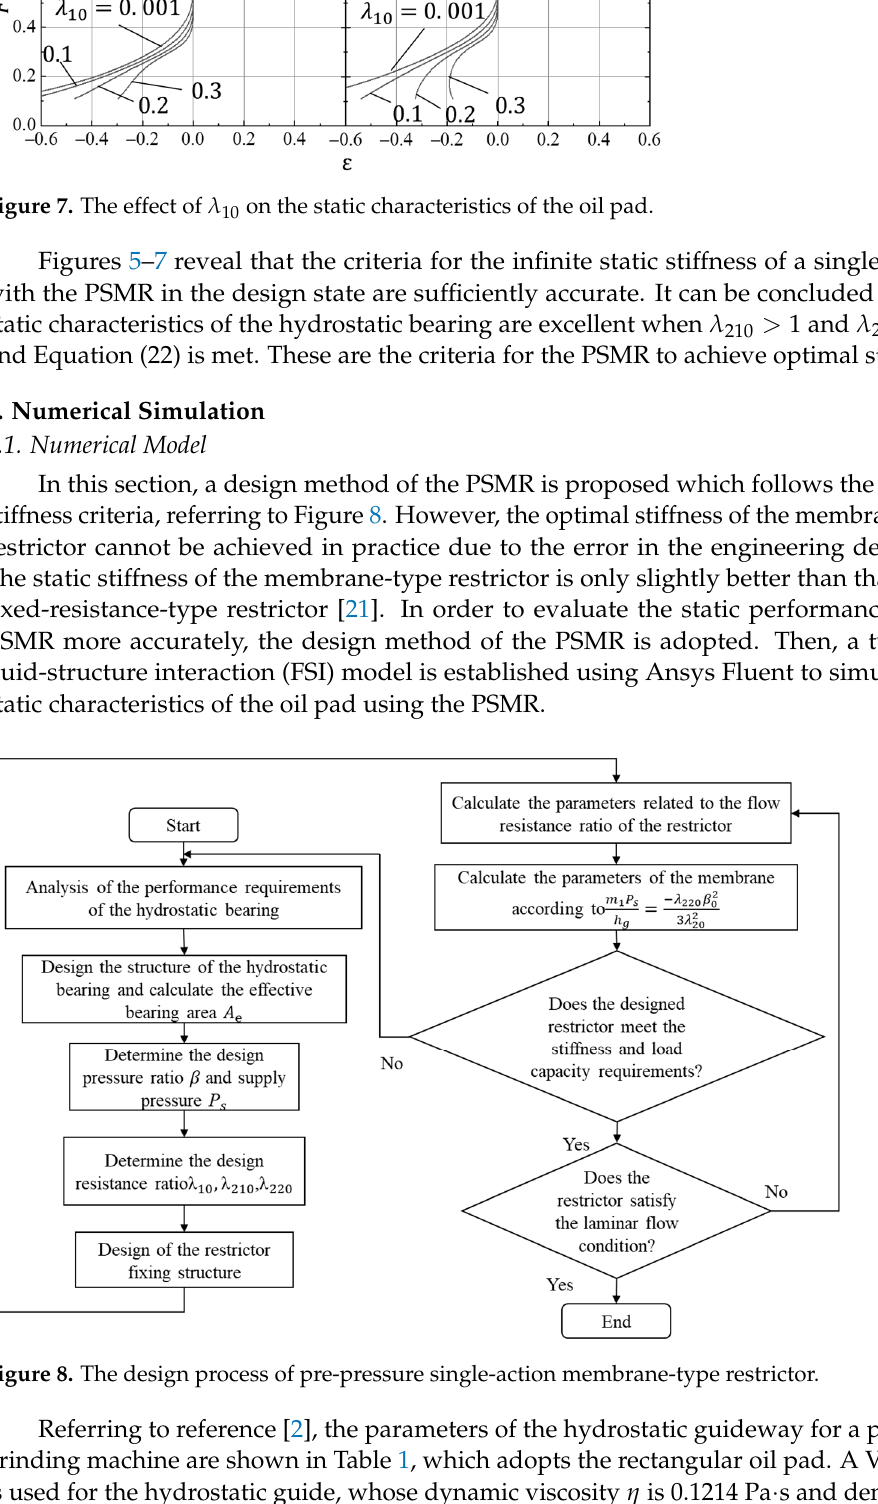
Table 1. Parameters of the hydrostatic bearing system.